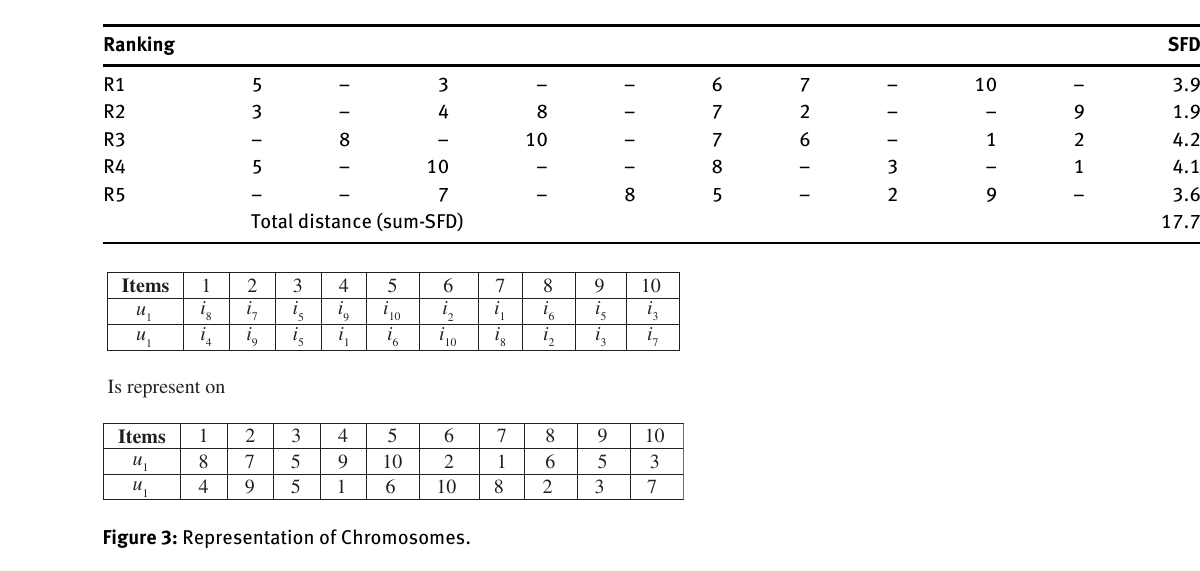
Table 2: Example of Fitness Function (Sum-SFD).